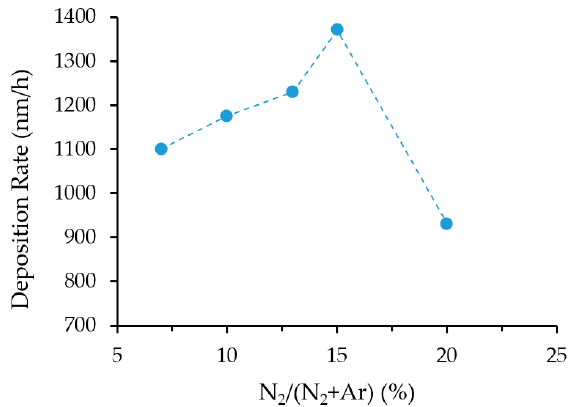
Figure 2. Variation of the deposition rate of Ta–Si–N films as a function of the N 2 /(N 2 + Ar) percentage.